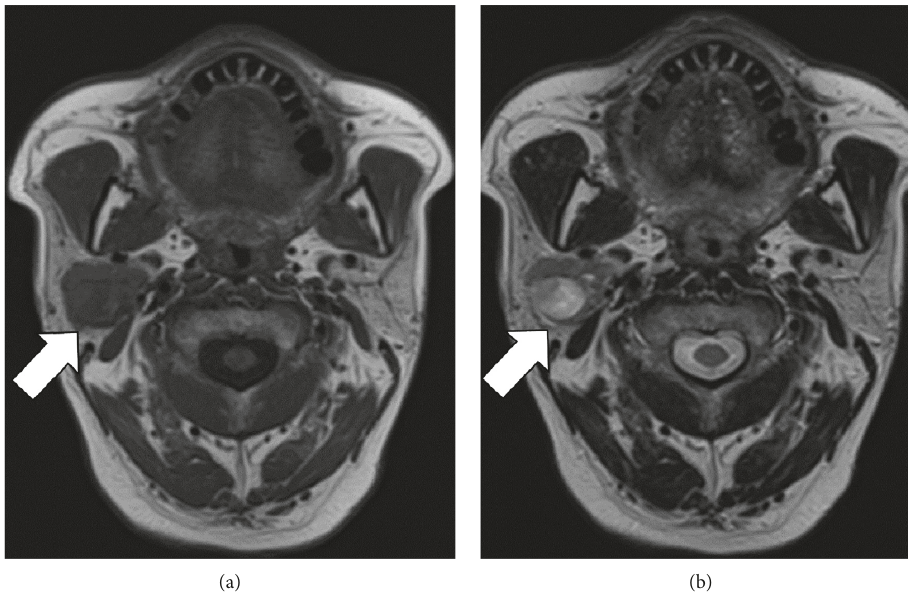
Figure 2: MR imaging findings. (a) A T1-weighted image showing the tumor to have lower intensity than that of the native parotid tissue. (b) A T2-weighted image showing the tumor to have an intermediate signal intensity and partial